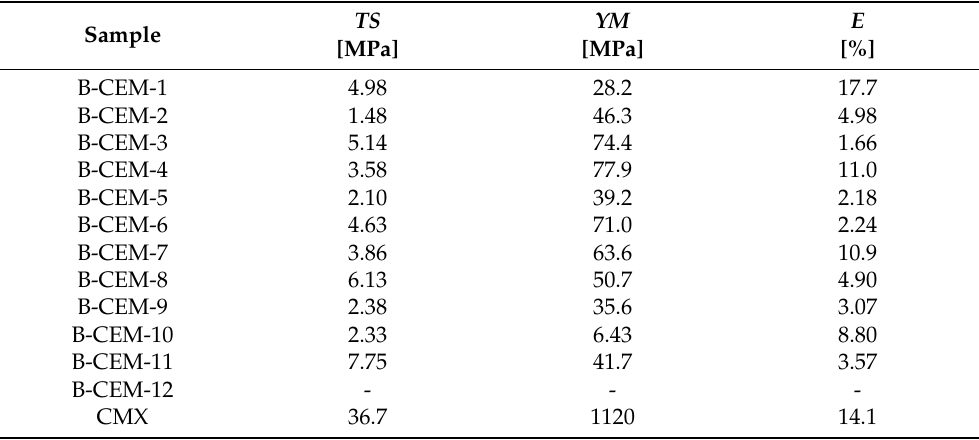
Table 3. Maximum tensile strengths ( TS ), Young’s moduli ( YM ), and elongations at breaking point ( E ) of B-CEMs and CMX (a commercial CEM). The properties of B-CEM-12 could not be measured, owing to its